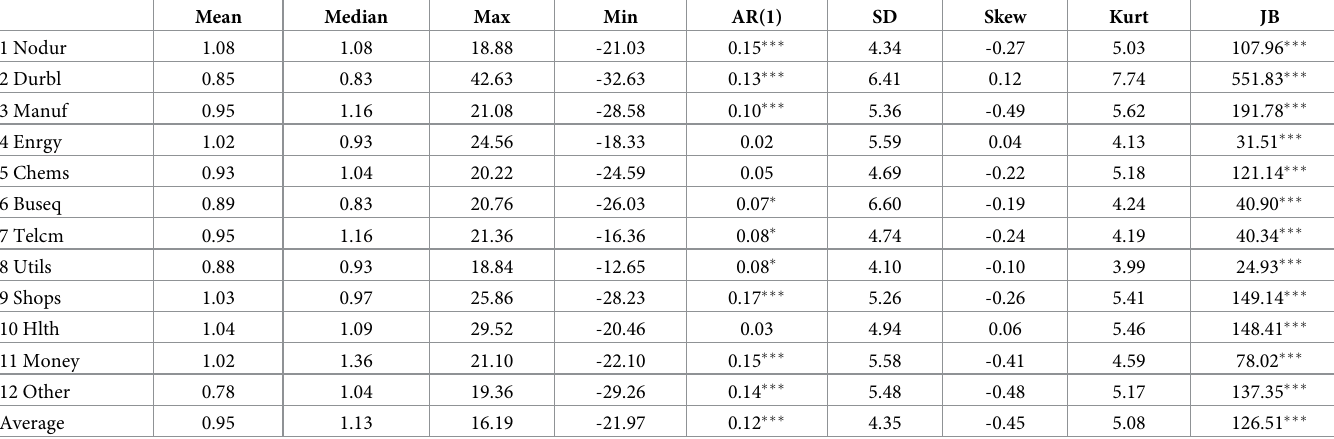
Table 1. Descriptive statistics for the Fama-French sector monthly returns (1968/01 to 2016/12).